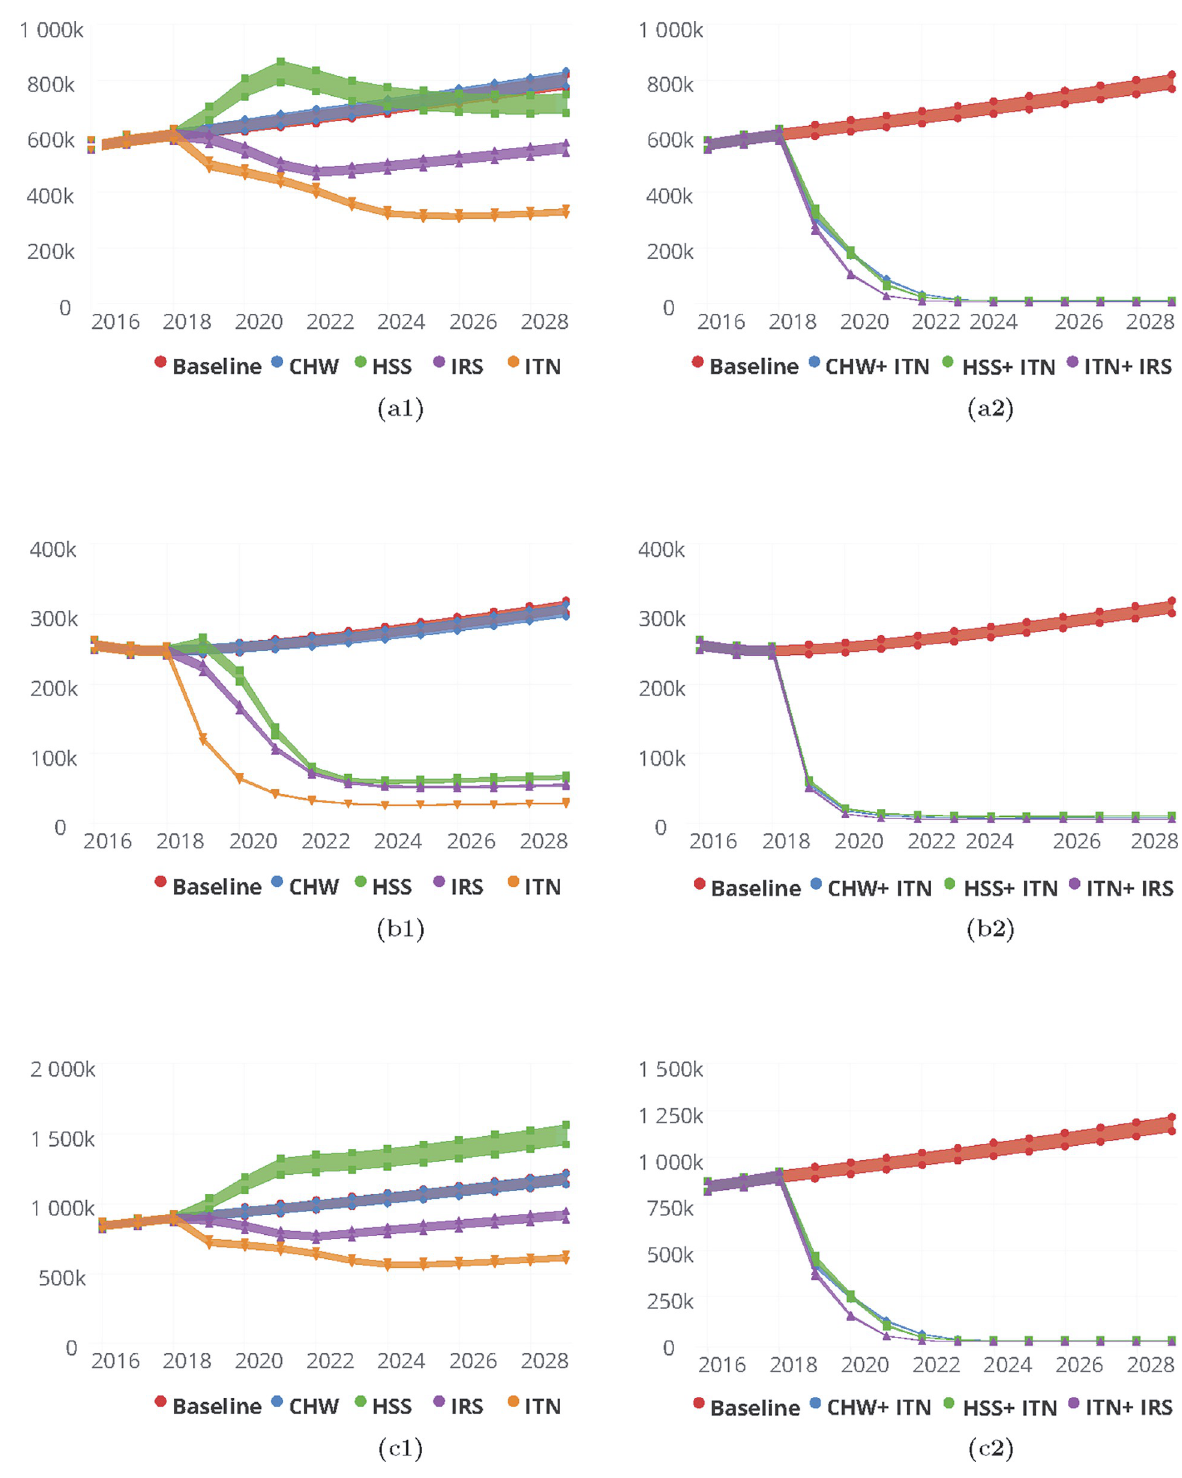
Fig 9. Predictions for malaria incidence for various intervention packages, singly (a1-c1) for Community Health Worker (CHW), Health System Strengthening (HSS), Indoor Residual Spraying (IRS), and Insecticide Treated bednets (ITN) and in combination (a2-c2) for CHW/CHPS + ITN, HSS + ITN and ITN + IRS for the Central (a1 and a2), Greater Accra (b1 and b2) and Western (c1 and c2) Regions respectively.